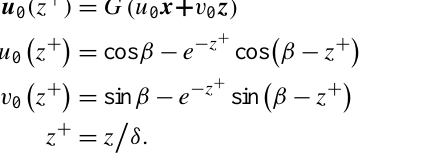
Fig. 1. The coordinate system used in this study with definitions of the main vectors and angles. The orientation of the LES compu- tational domain is sketched by the shaded rectangle. x axis points due east, y axis points due north and z axis is normal to the planet surface at given latitude ϕ